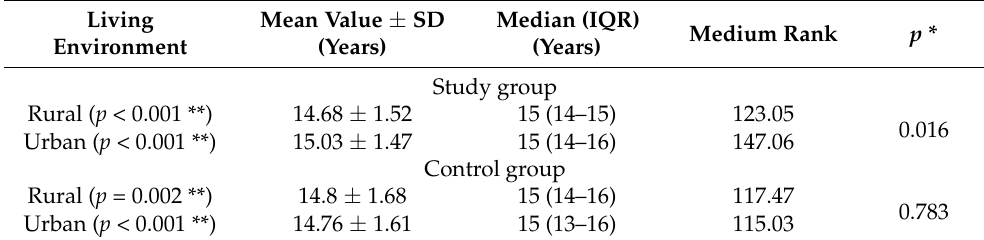
Table 2. Comparison of participants’ ages in relation to the living